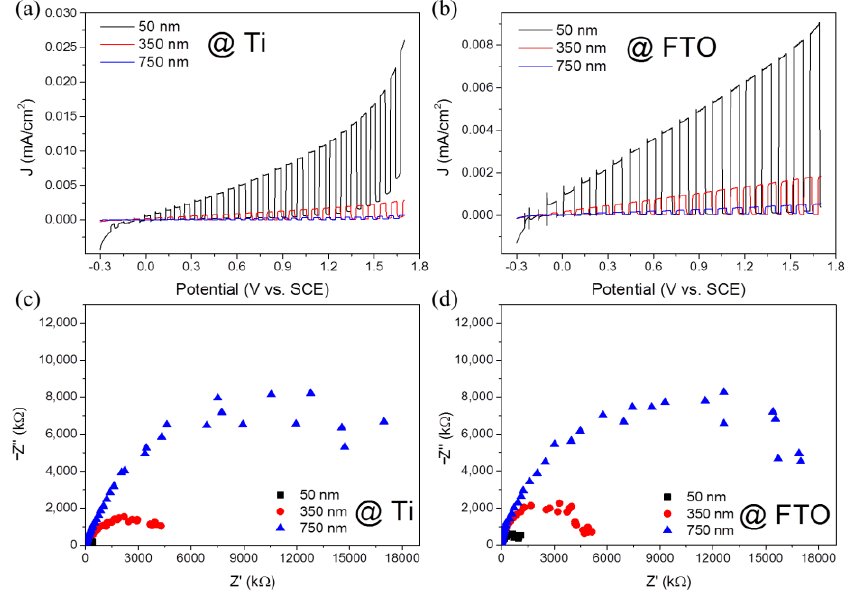
Figure 7. The influence of layer thickness on the obtained photocurrent densities presented in chopped current–voltage curves for layers deposited on ( a ) Ti substrate and ( b ) FTO substrate. The presented in Nyquist plots for layers deposited on ( c ) Ti substrate and ( d ) FTO